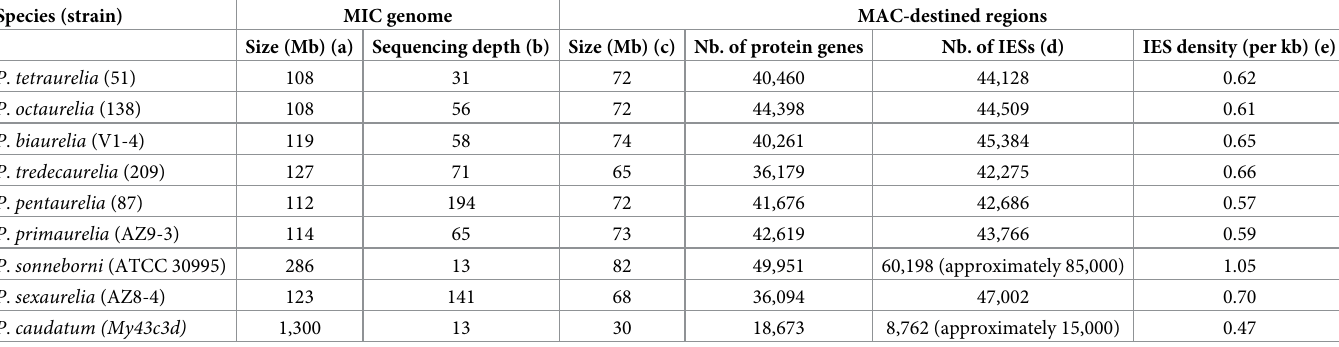
Table 1. Characteristics of analyzed genomes. Species are ordered according to the phylogeny (Fig 1). (a) MIC genome size (in Mb) was estimated based on k-mer counts (see S1 Table for additional estimates based on flow cytometry). (b) Sequencing depth in MIC-specific regions estimated from the distribution of k-mer counts (S2 Fig). (c) Size of constitutive MAC genome assembly. (d) The sensitivity of IES detection was limited in P . caudatum and P . sonneborni because of the relatively low sequencing depth of their MIC genome. Estimates of total number of IESs, based the IES density observed in regions with sufficient read depth (see e), are indicated in parenthesis for these 2 species. (e) IES density measured in MAC-destined sequences, after exclusion of regions with insufficient MIC read depth ( < 15X). Species